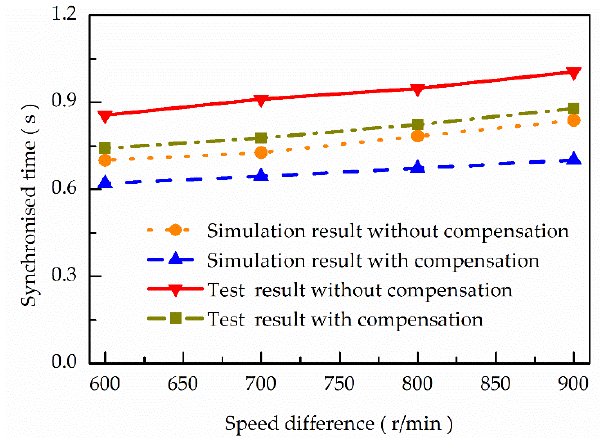
Figure 9. Synchronous time contrast with or without compensation.